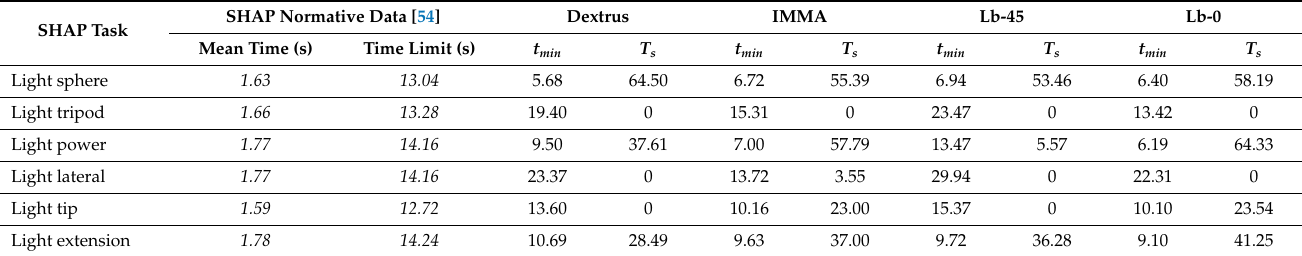
Table 2. Transformed Time Scores for each LAO task, calculated from the t min registered. SHAP